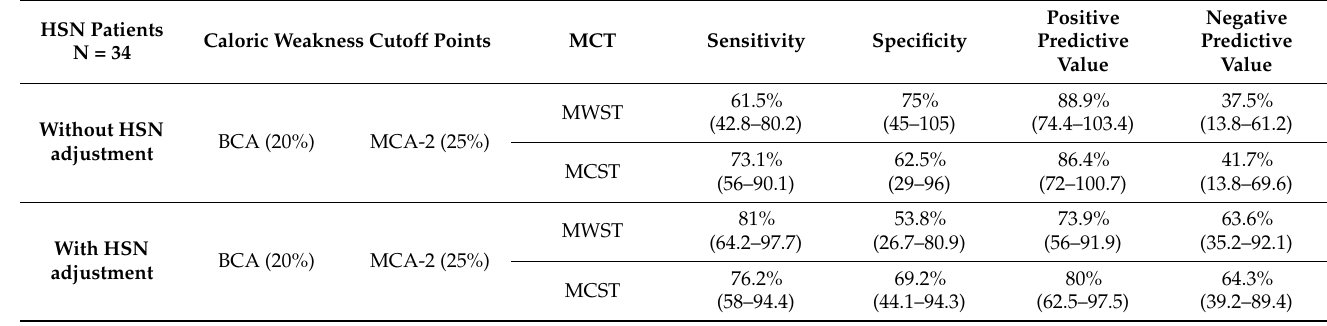
Table 3. Evaluation of the screening effect of MCT for both warm and cold stimulation compared to the BCT in patients with horizontal spontaneous nystagmus (HSN) with and without HSN adjustments using the MCA-2